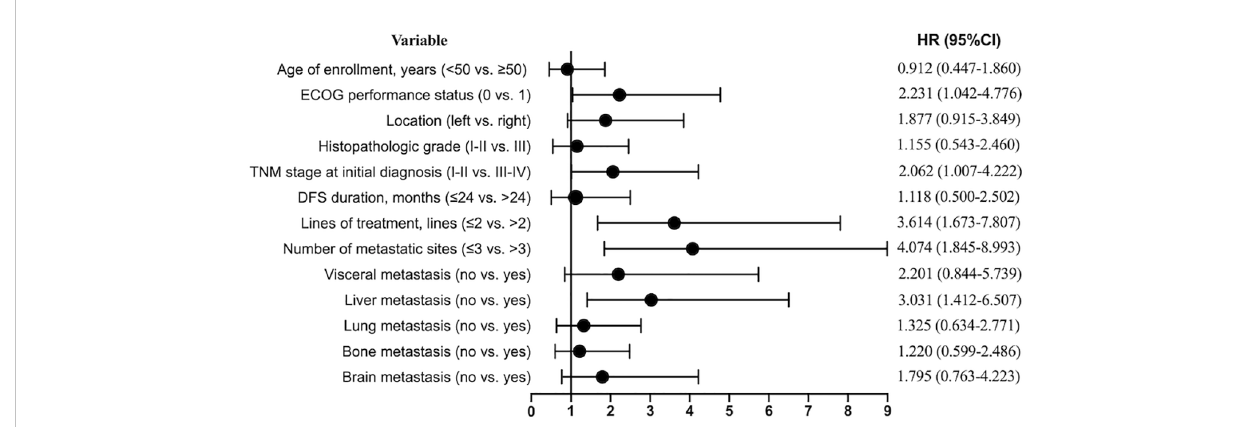
FIGURE 2 Forest plot of cox univariate regression analysis for progression-free survival. HR, hazard ratio; CI, con fi dence interval; ECOG, Eastern Cooperative Oncology Group; TNM stage, the stage of tumor, node and metastasis; DFS, disease free